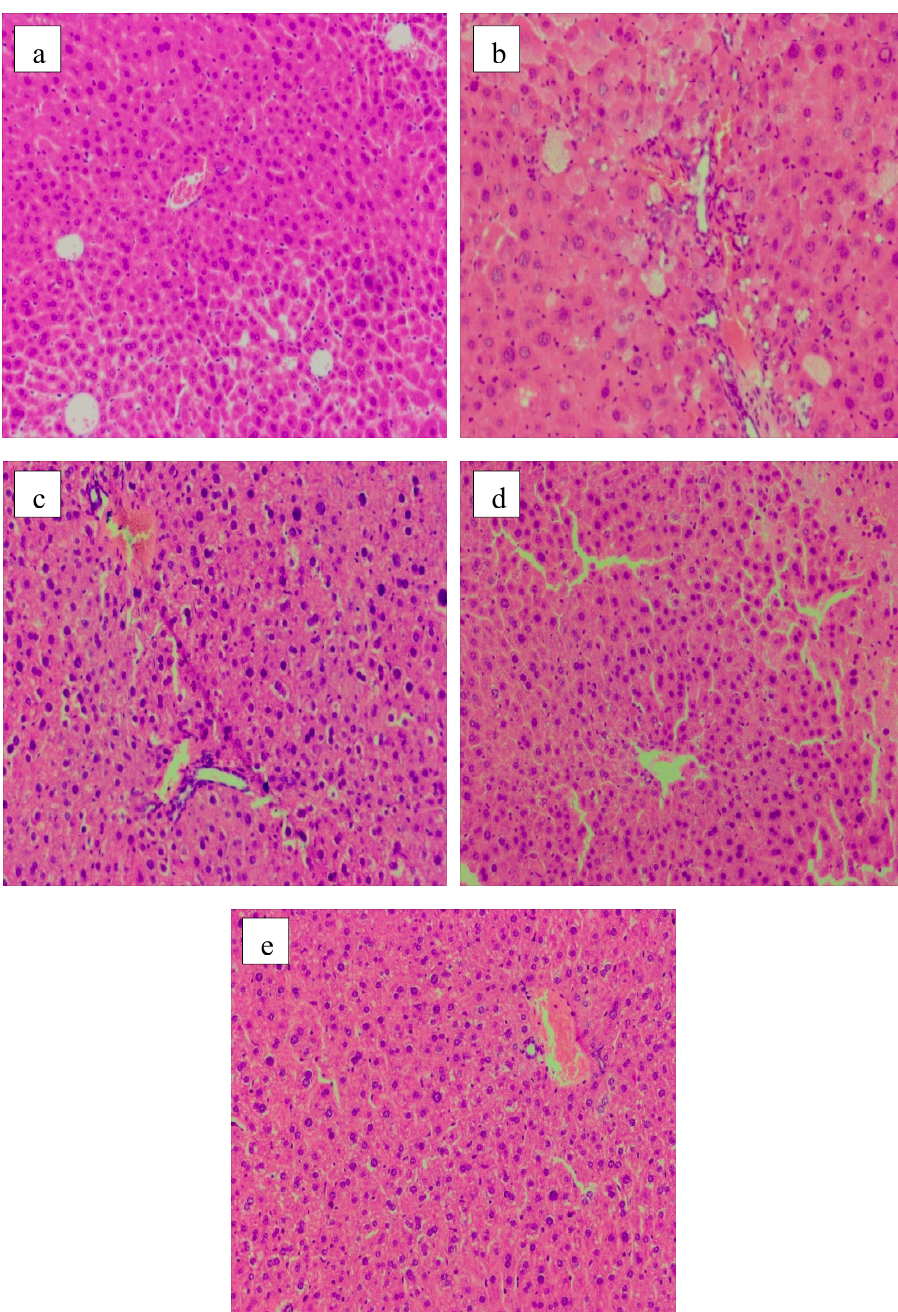
Figure 4. Liver histology images (HE staining, 100×). ( a ) NG; ( b )MG; ( c )PG; ( d )LP; ( e )HP.